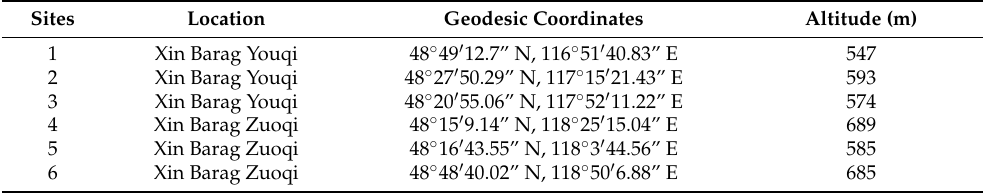
Figure 5. Location of the studied sites for the studied locations, and pictures of the vegetation on site. Table 4. Details of studied sites, their location, geodesic coordinates, and altitude (m).